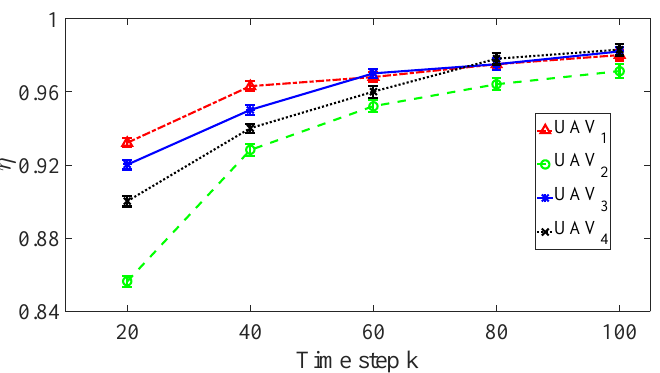
Figure 11. Closed trajectory of UAVs.